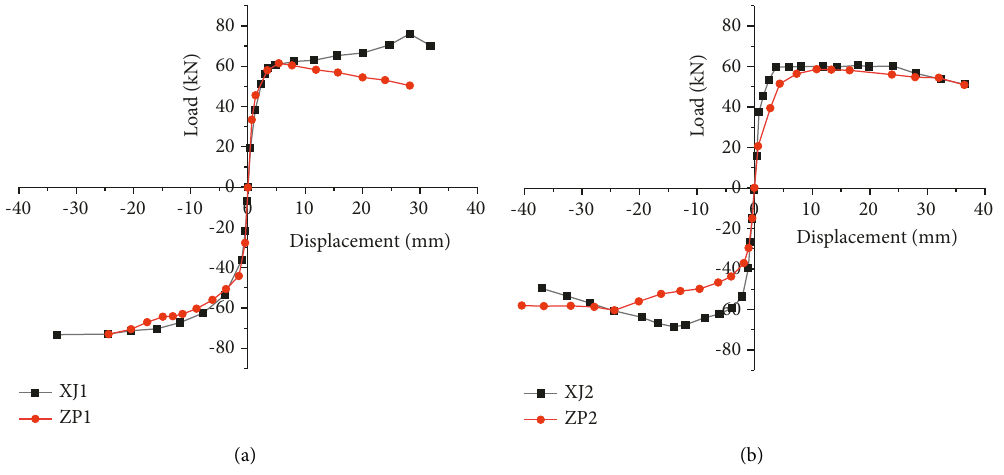
Figure 7: Skeleton curves of test pieces. (a) Skeleton curves of XJ1 and ZP1. (b) Skeleton curves of XJ2 and ZP2.